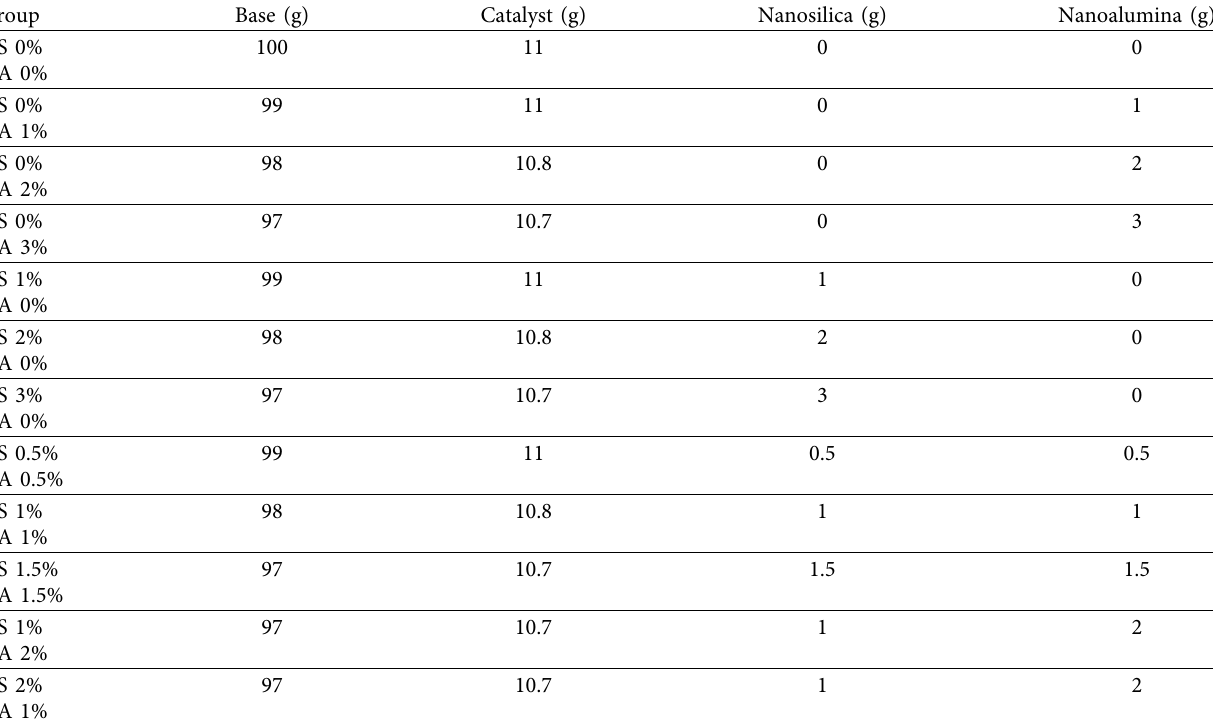
Table 1: Te amount of silicone base (part A) mixed with either wt.% of nanosilica (NS) or wt.% of nanoalumina (NA) or a combination of nanosilica and nanoalumina (NSA) and catalyst (part B) for Tech-sil25 silicone